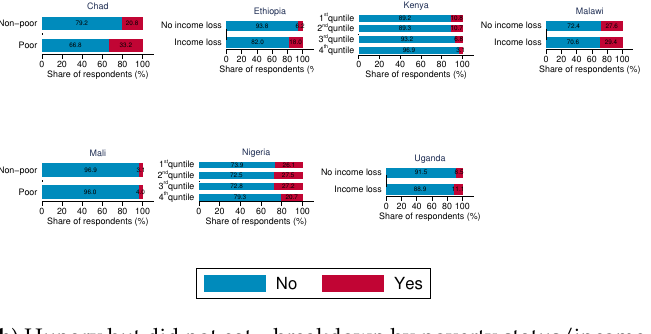
Figure 3. Food insecurity—breakdown by gender of household head and poverty status/income quintile/income loss.